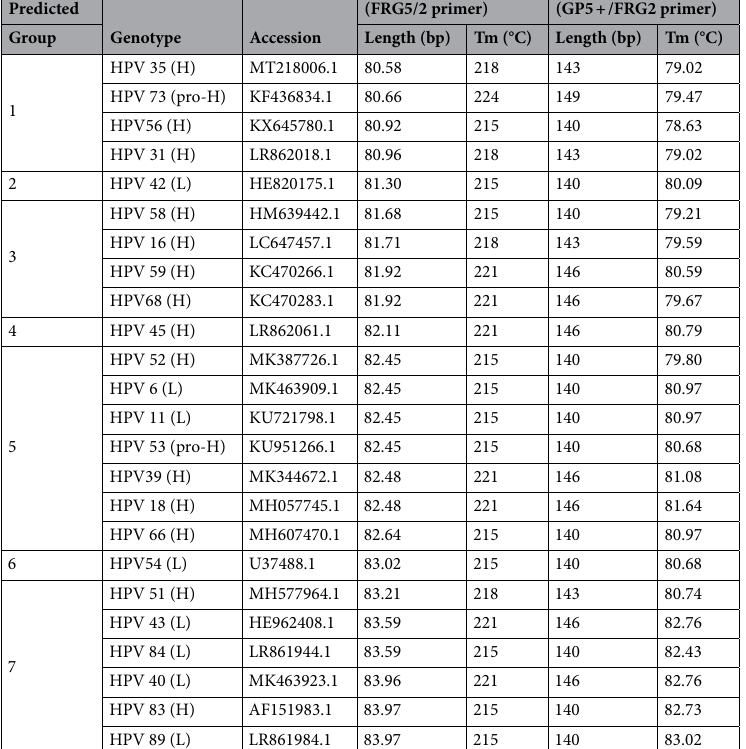
Table 1. In the silico prediction of melting temperature of different human papillomavirus genotypes using CLC Genomics Workbench 12 bioinformatics application (salt = 0.2 M). H High risk; L Low risk; pro-H probably High risk.